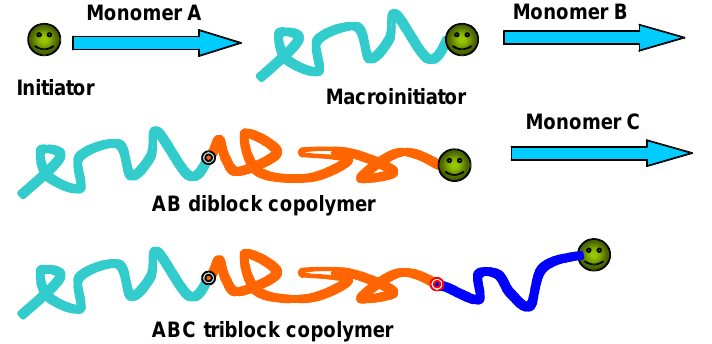
Figure 2. Scheme of preparation of well-defined PRBCs by direction